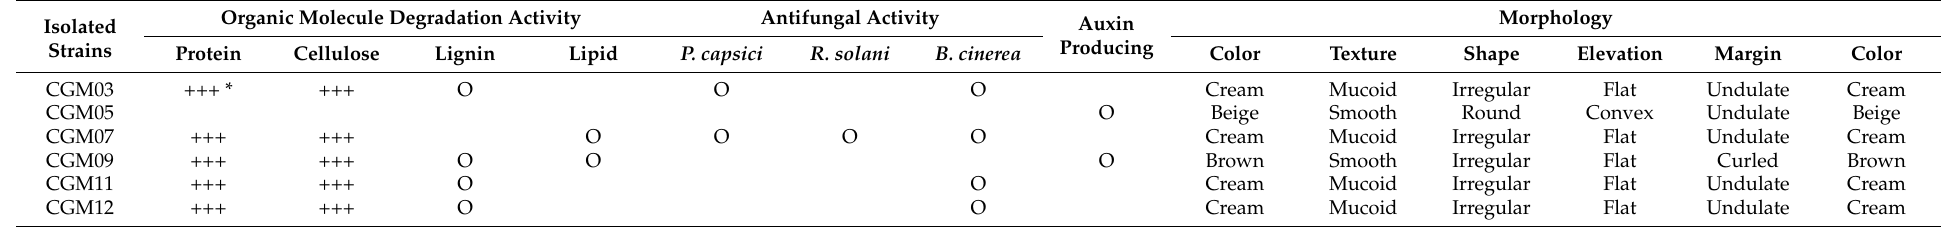
Table 2. Distribution of the morphological, characteristics, extracellular enzyme, antifungal, and auxin-producing activities among the